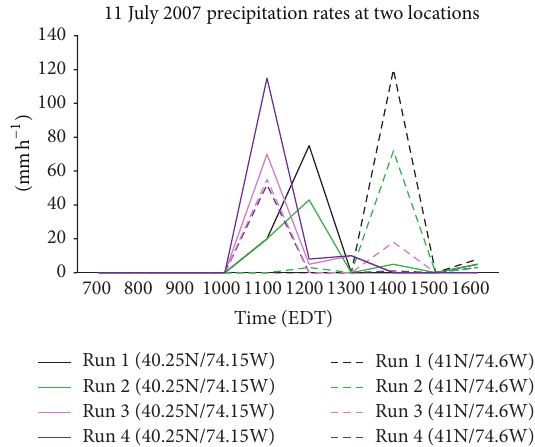
Figure 17: Precipitation rates for all July 11, simulations for two major storms over NJ, for City and No City